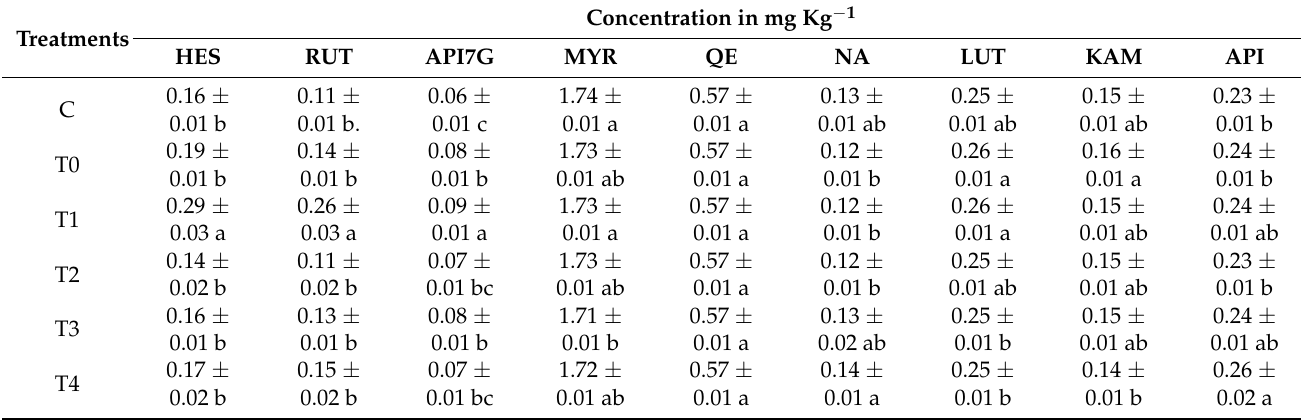
Table 4. Flavonoid profiles of rice grain samples after exposure of different Arsenic (As) and combined As and orthphosphate (P) treatments. Treatments, C and T0, indicate untreated control, and 10 mg kg − 1 As treated group, respectively. The base soil As content in control group was 35 µ g kg − 1 . T1, T2, T3, and T4 denote combined treatments, 10 mg kg − 1 As + 10 mg kg − 1 P, 10 mg kg − 1 As + 20 mg kg − 1 P, 10 mg kg − 1 As + 30 mg kg − 1 P, and 10 mg kg − 1 As + 40 mg kg − 1 P, respectively. All values are expressed as a mean ± standard error (SE) of three biological and two technical replicates per sample. Significantly differences ( p < 0.05) among different treatments are shown by different letters. Treatments HES